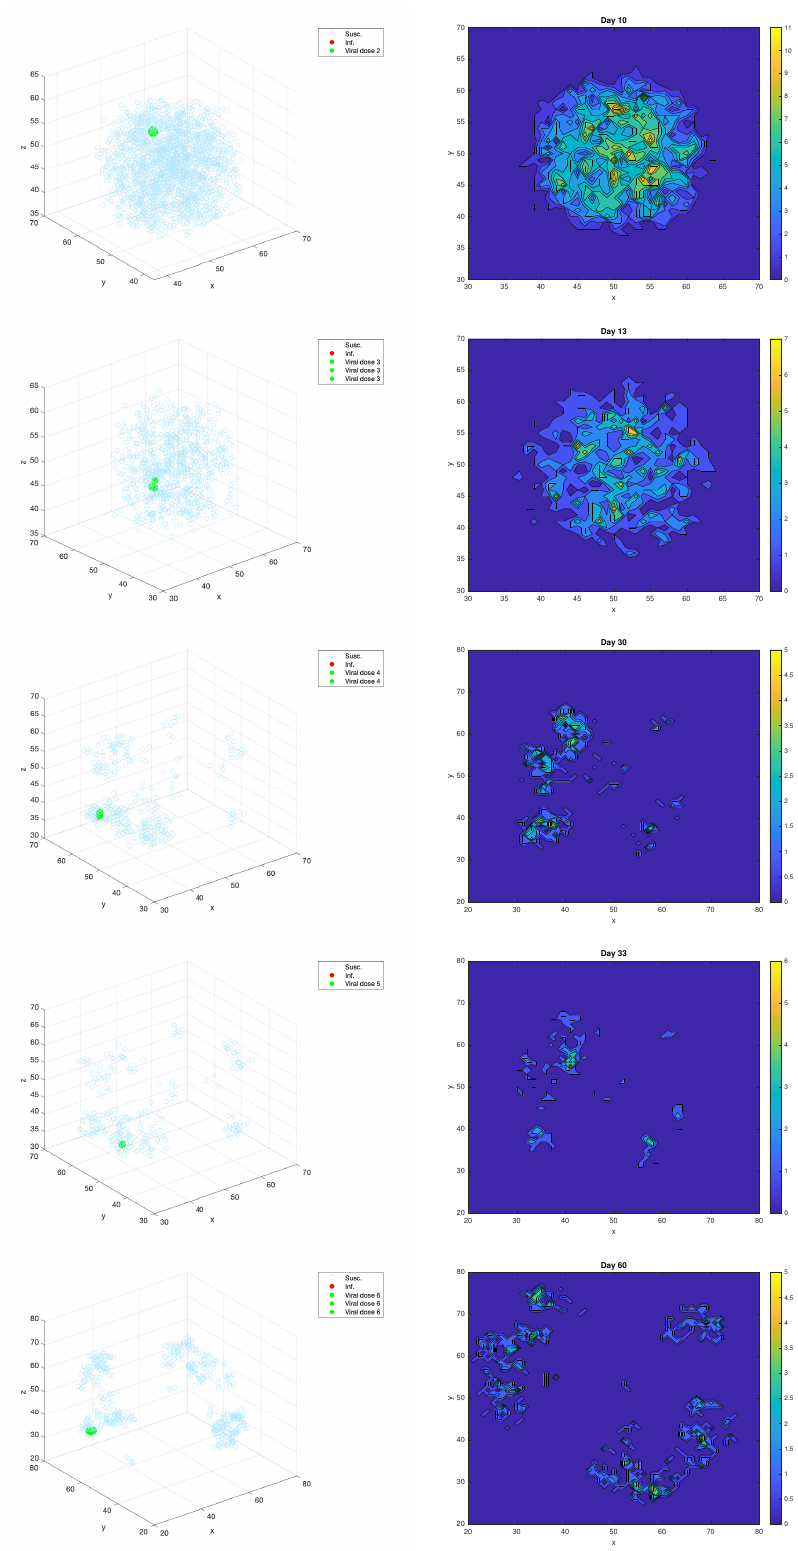
Figure 7. The chosen viral dosing locations for Doses 2–6 in the realization of the ABM. The locations in the 3-D domain are shown on the left, while the two-dimensional tumor cell density is shown on the right, obtained from projecting the z dimension onto the xy